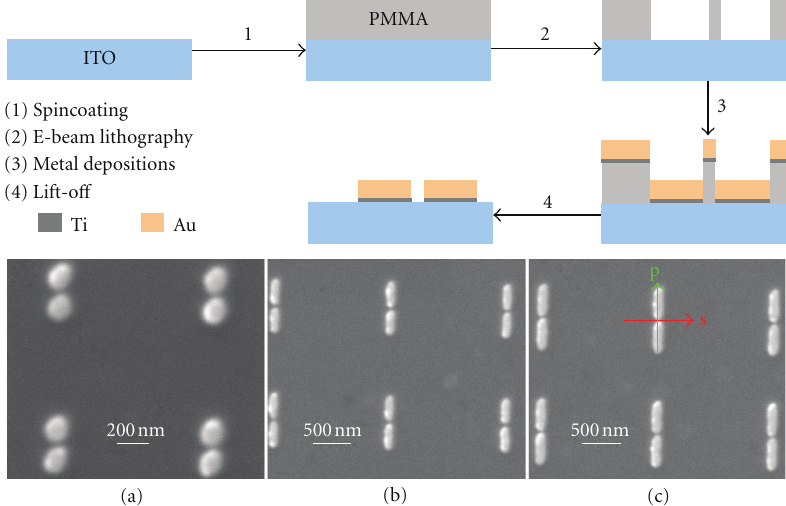
Figure 1: Fabrication steps of nanoantenna arrays using e-beam lithography and metal depositions. SEM images of selected nanoantenna arrays, used in the reported studies, are presented in (a) for dimers, and in (b) and (c) for nanorods with di ff erent lengths and therefore di ff erent ARs. The arrows in (c) define the used excitation polarizations, with p-polarization along the long axis of the nanostructures and s perpendicular to the long